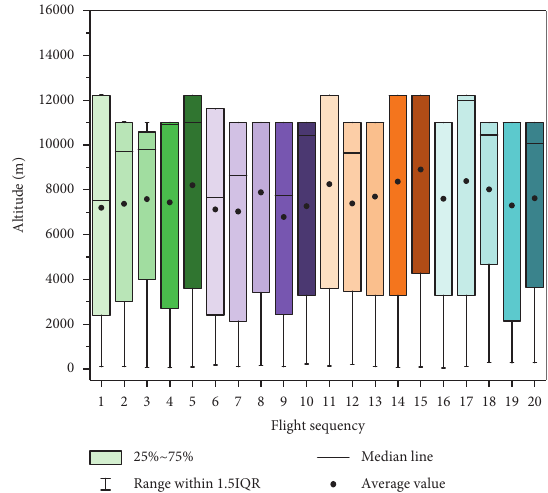
Figure 3: The flight operation situation of A330-200 between Beijing and